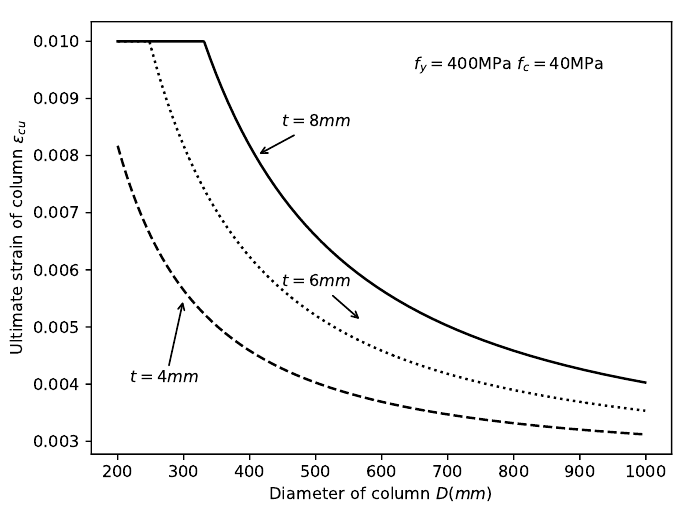
Figure 11. Effect of material strength on ε cu .